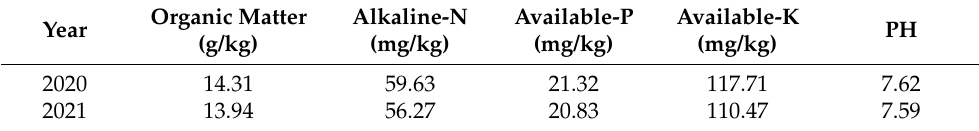
Table 1. Soil base fertility information of the experimental site.